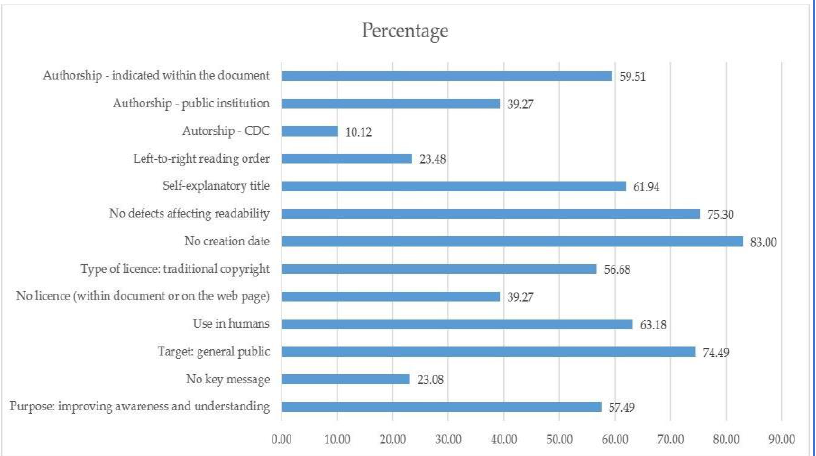
Figure 2. Summary of the most frequent characteristics of the included infographics. CDC: Center for Disease Control and Prevention.